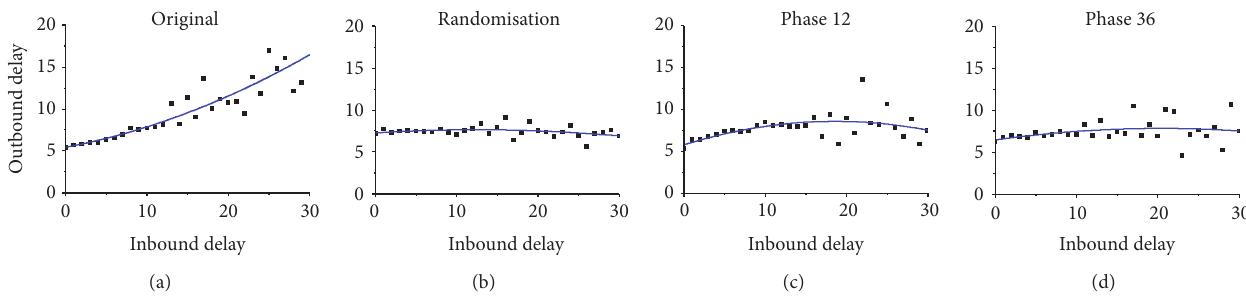
Figure 2: Validation of the meaning of the horizontal fit. From (a) to (d), the panels represent the scatter plot for the following: the original Munich airport data; a randomisation of the delay data; a phase of 12 hours; and a phase of 36